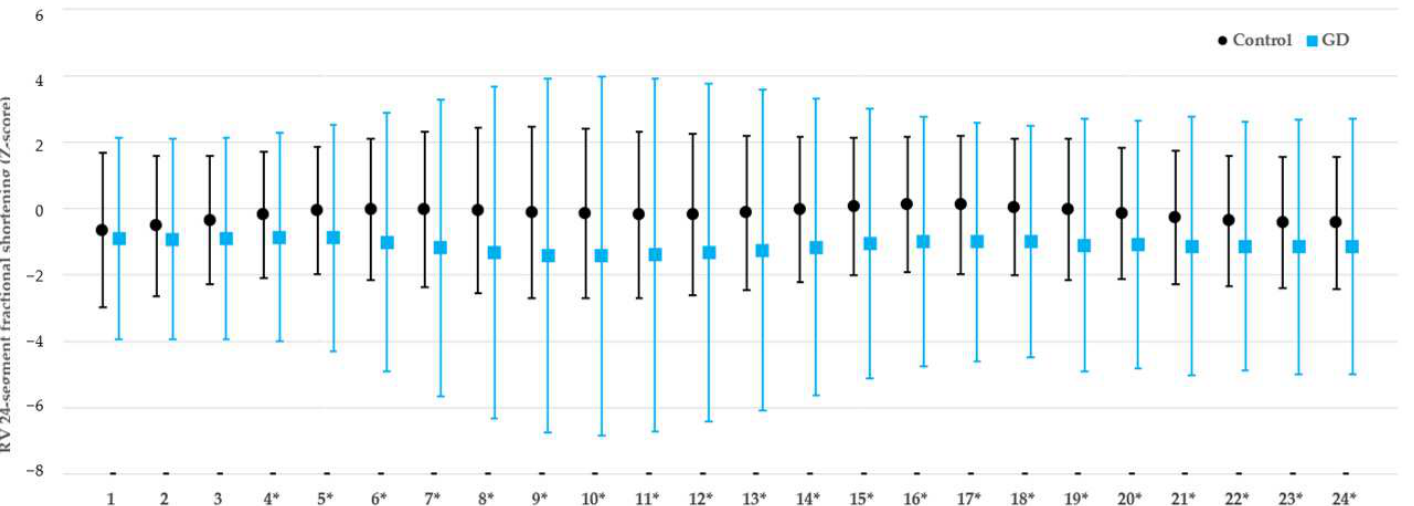
Figure 2. Comparison of the 24-segment fractional shortening of the right ventricle between fetuses exposed to gestational diabetes mellitus and healthy fetuses. RV, right ventricle; FS, fractional shortening; GD, gestational diabetes mellitus; *, p -value <